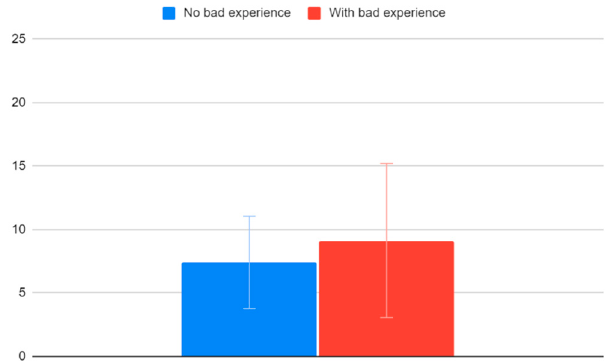
Figure 8. VACS values and bad vaccination experience history.